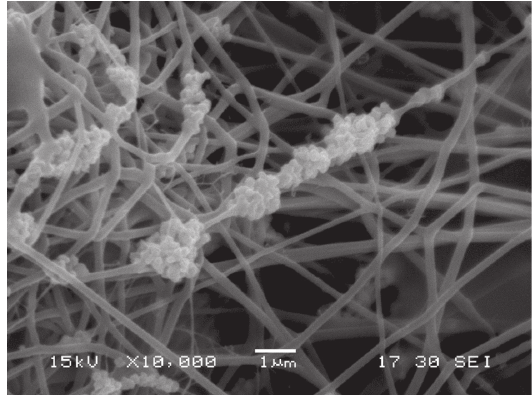
Figure 4. SEM images of PVA/H 0.2-0.5 mL/h; distance : 10 cm; BT content: 4,7%